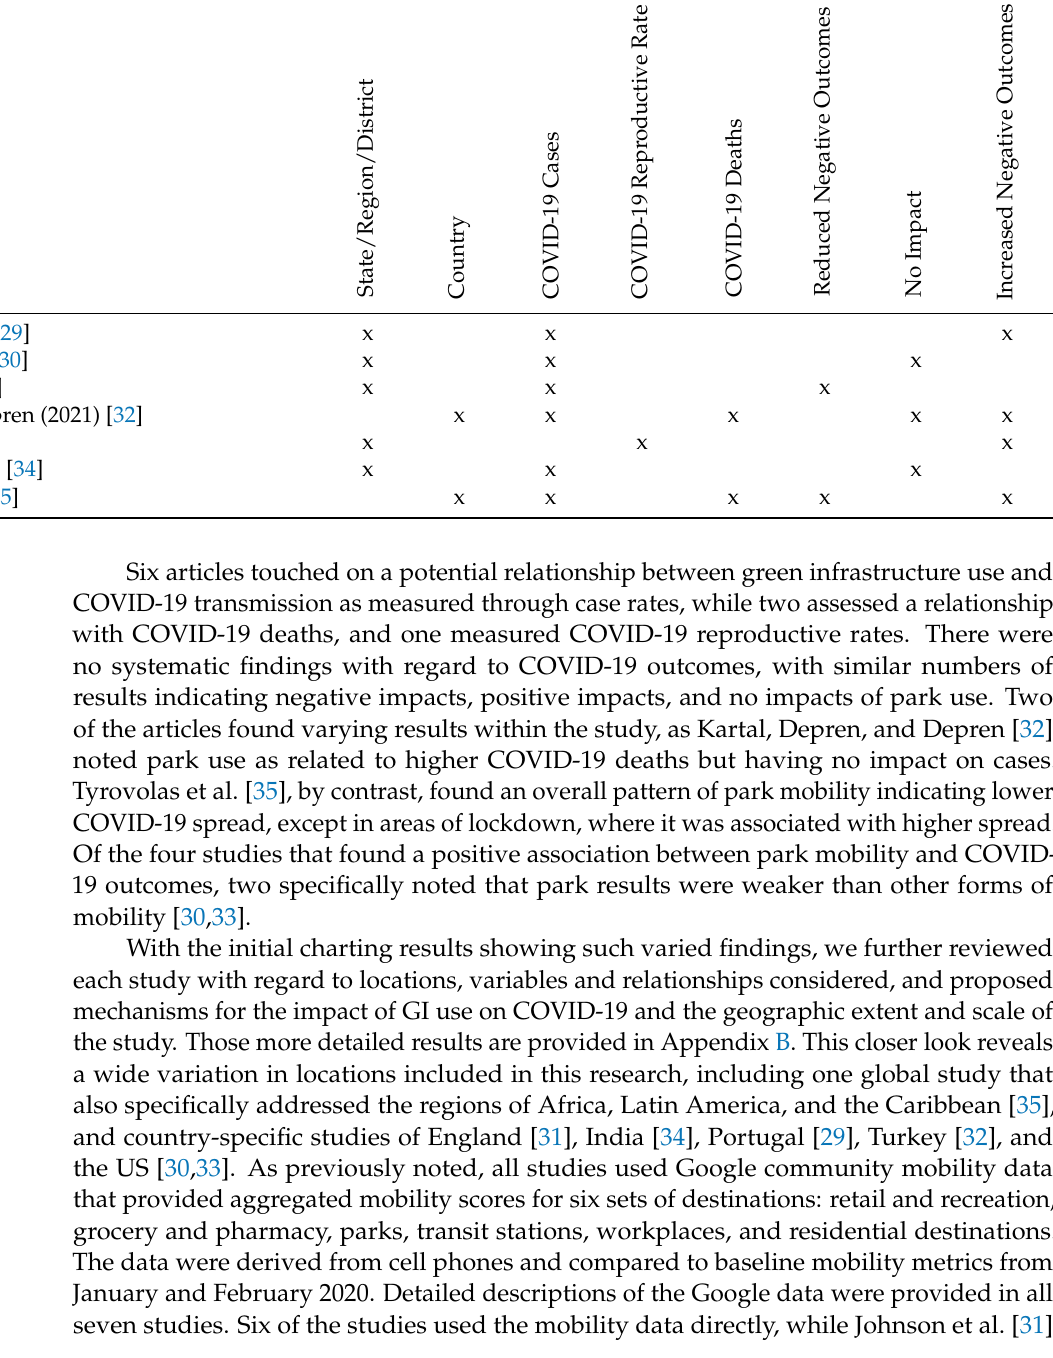
Unit of Health Outcomes Impact of GI Analysis